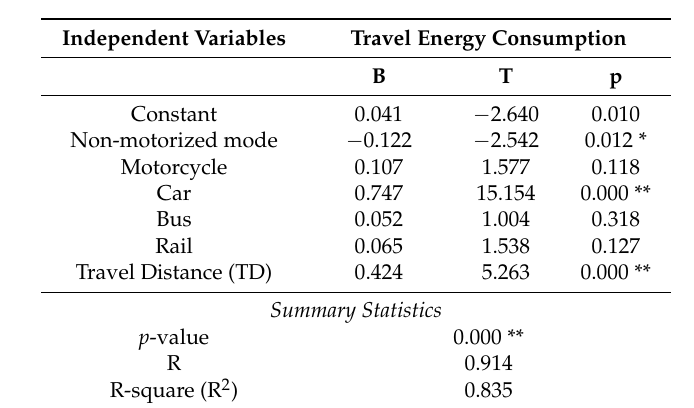
Figure 4. Database construction and analysis method. Table 6. Travel energy consumption regression model.